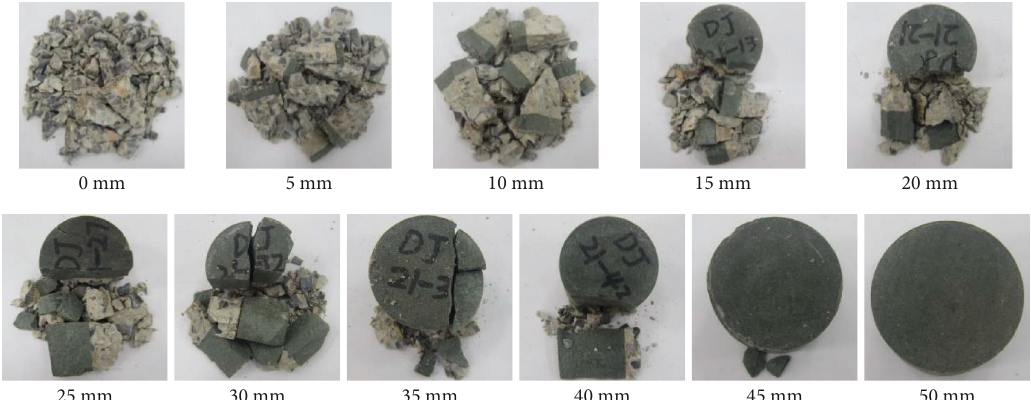
Figure 10: Dynamic compaction damages the morphology of rock-concrete combined bodies with different thickness